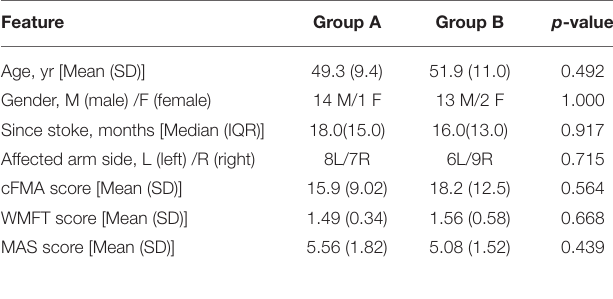
TABLE 1 | Baseline data comparisons between Group A and Group B. Feature